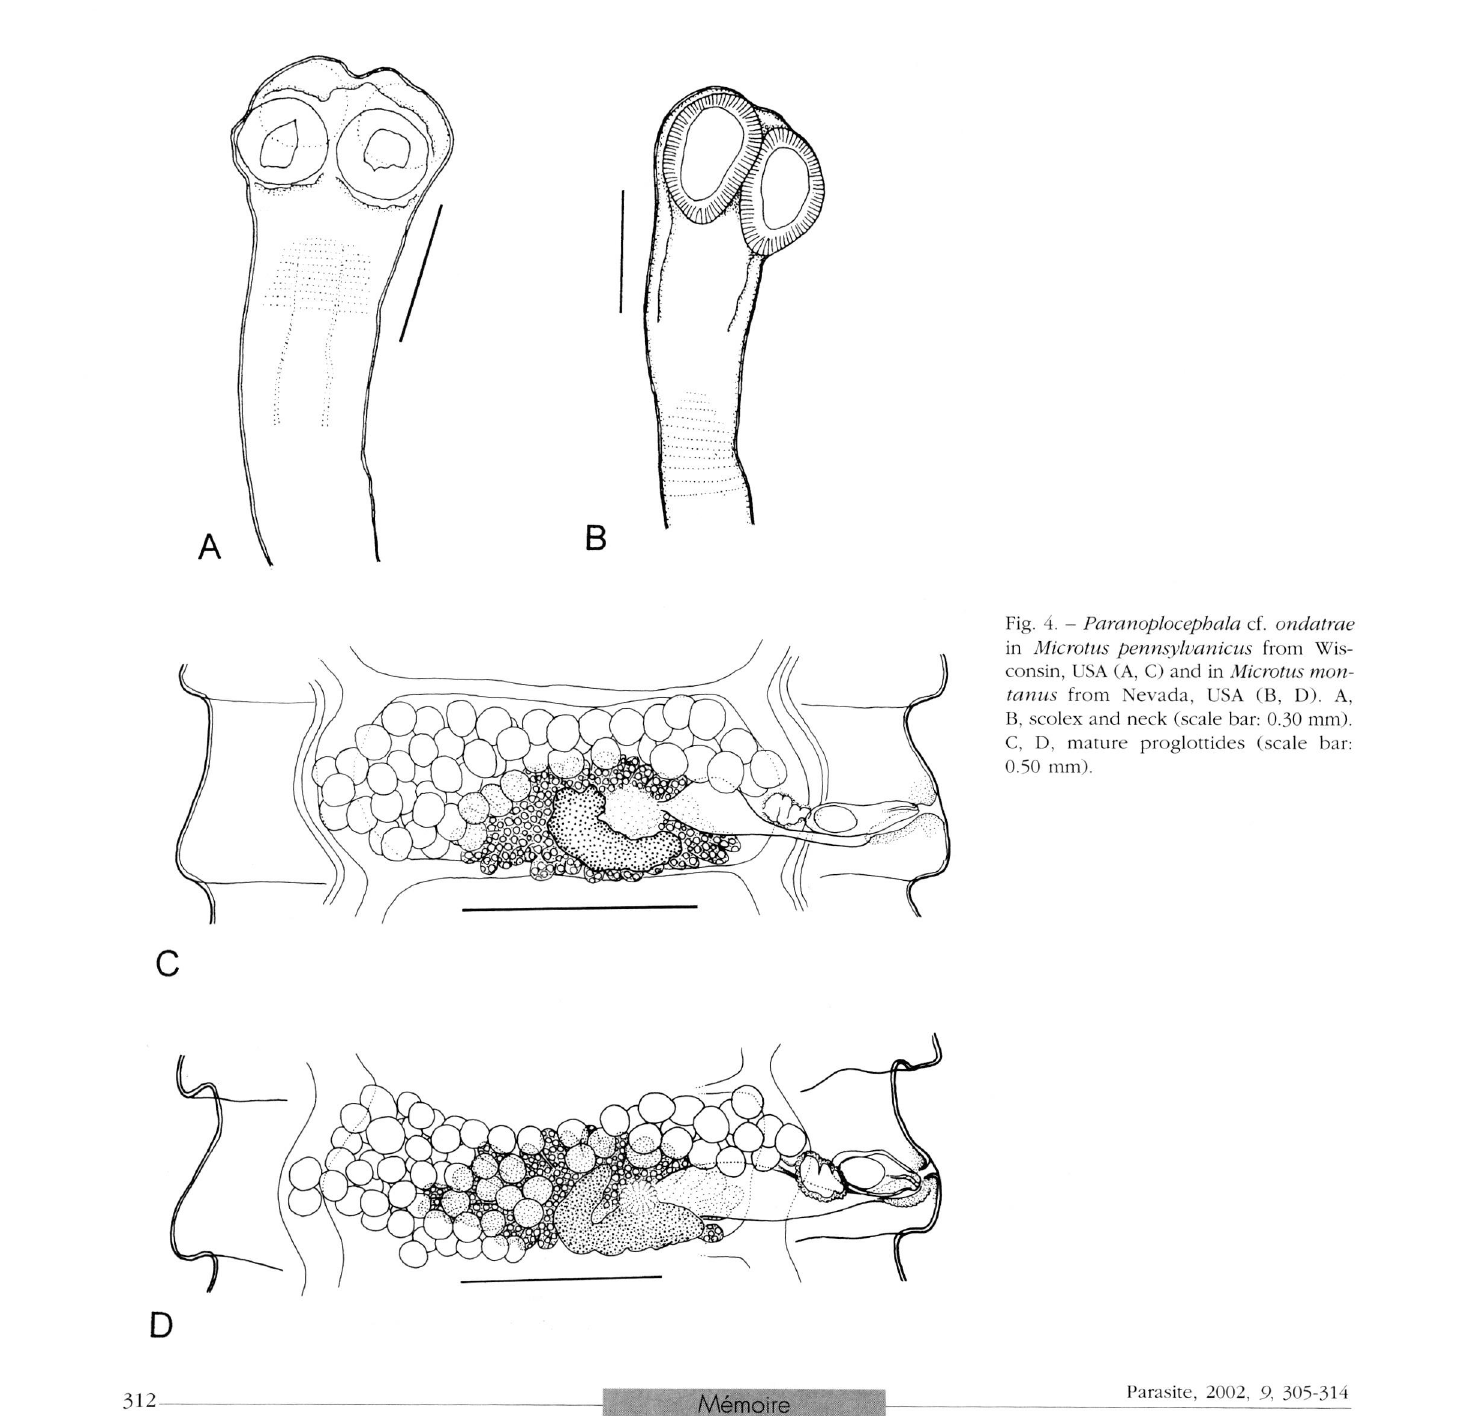
Fig. 4. - Paranoplocepbala cf. ondatrae in Microtus pennsylvanicus from Wis­ consin, USA (A, C) and in Microtus mon- tanus from Nevada, USA (B, D). A, B, scolex and neck (scale bar: 0.30 mm). C, D, mature proglottides (scale bar: 0.50